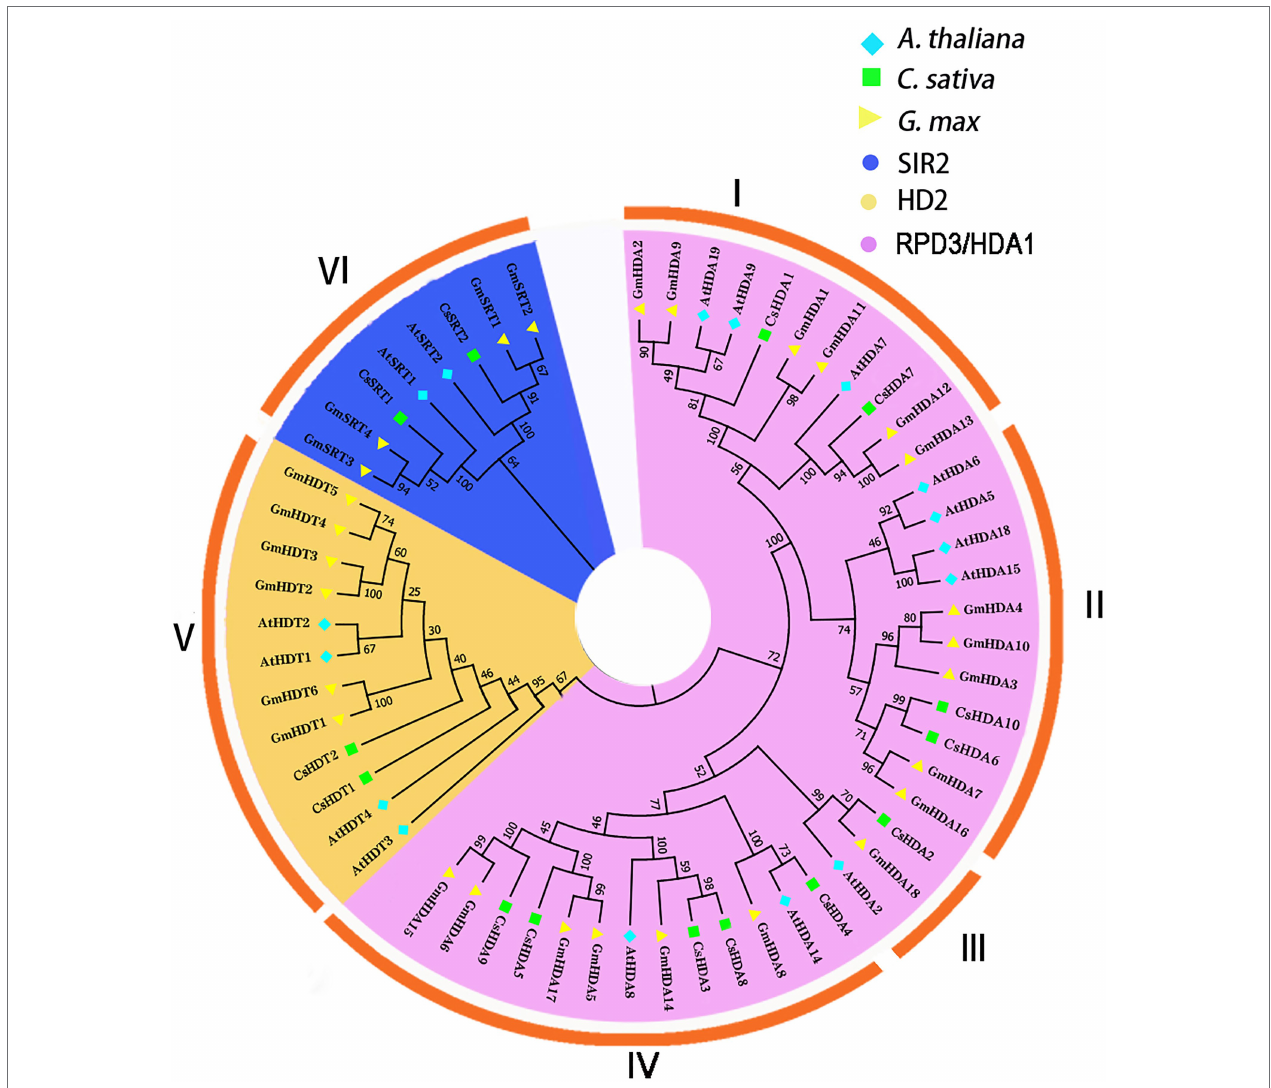
FIGURE 2 | An unrooted phylogenetic tree was constructed with the HDAC domain amino acid sequences of Arabidopsis thaliana, Cannabis sativa , and Glycine max. A neighbor-joining tree was constructed using MEGA7 with 1,000 bootstrap replicates. The tree was divided into six groups that contained the RPD3/HDA1, SIR2, and HD2 subfamilies (I–IV: RPD3/HDA1; V: HD2; and VI: SIR2). The blue rhombus represents A. thaliana ; the green square indicates C. sativa ; and the yellow triangle represents G. max. The purple background shows the SIR2 subfamily; the yellow background refers to the HD2 subfamily; and the blue background represents the RPD3/HDA1